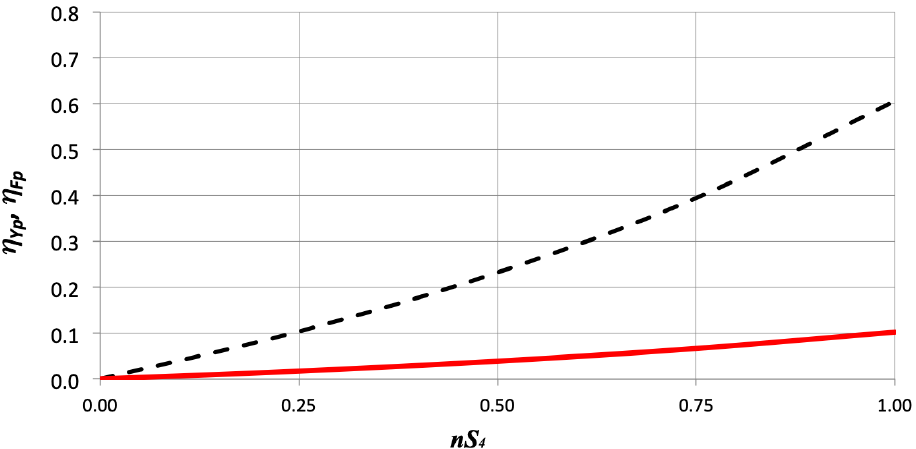
Figure 3. The increase in yeast production η Yp and fertilizer production η Fp versus the volume fraction n (the part of stream S 4 directed to the ES). The dotted line represents the theoretical increase, and the red line is the real increase possible to achieve, considering the data from the analyzed factory (at current efficiency of the ES).